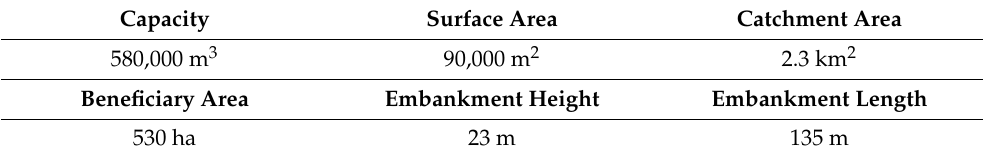
Table 1. Basic specifications of the Takayama